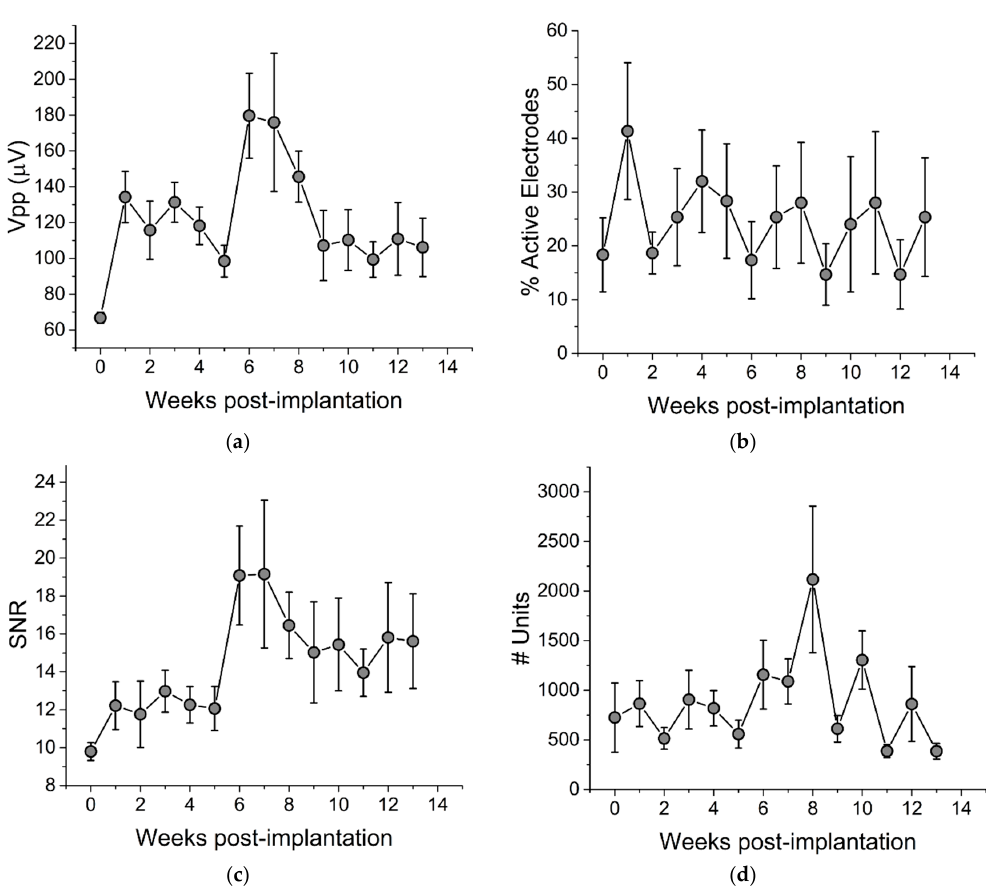
Figure 3. Chronic recording stability. ( a ) peak-to-peak voltage (Vpp), ( b ) active electrode yield %, ( c ) signal-to-noise ratio (SNR), and ( d ) number of units. Each time point reflects n = 75 electrodes, except weeks 0 and 5, which reflect n = 60 electrodes. Linear regression analysis indicates no change in Vpp, active electrode yield %, or SNR, while number of units increased slightly ( R 2 = 0.016, p = 0.02). Week 0 represents data taken on the day of implantation. Data are shown as mean ± SEM.